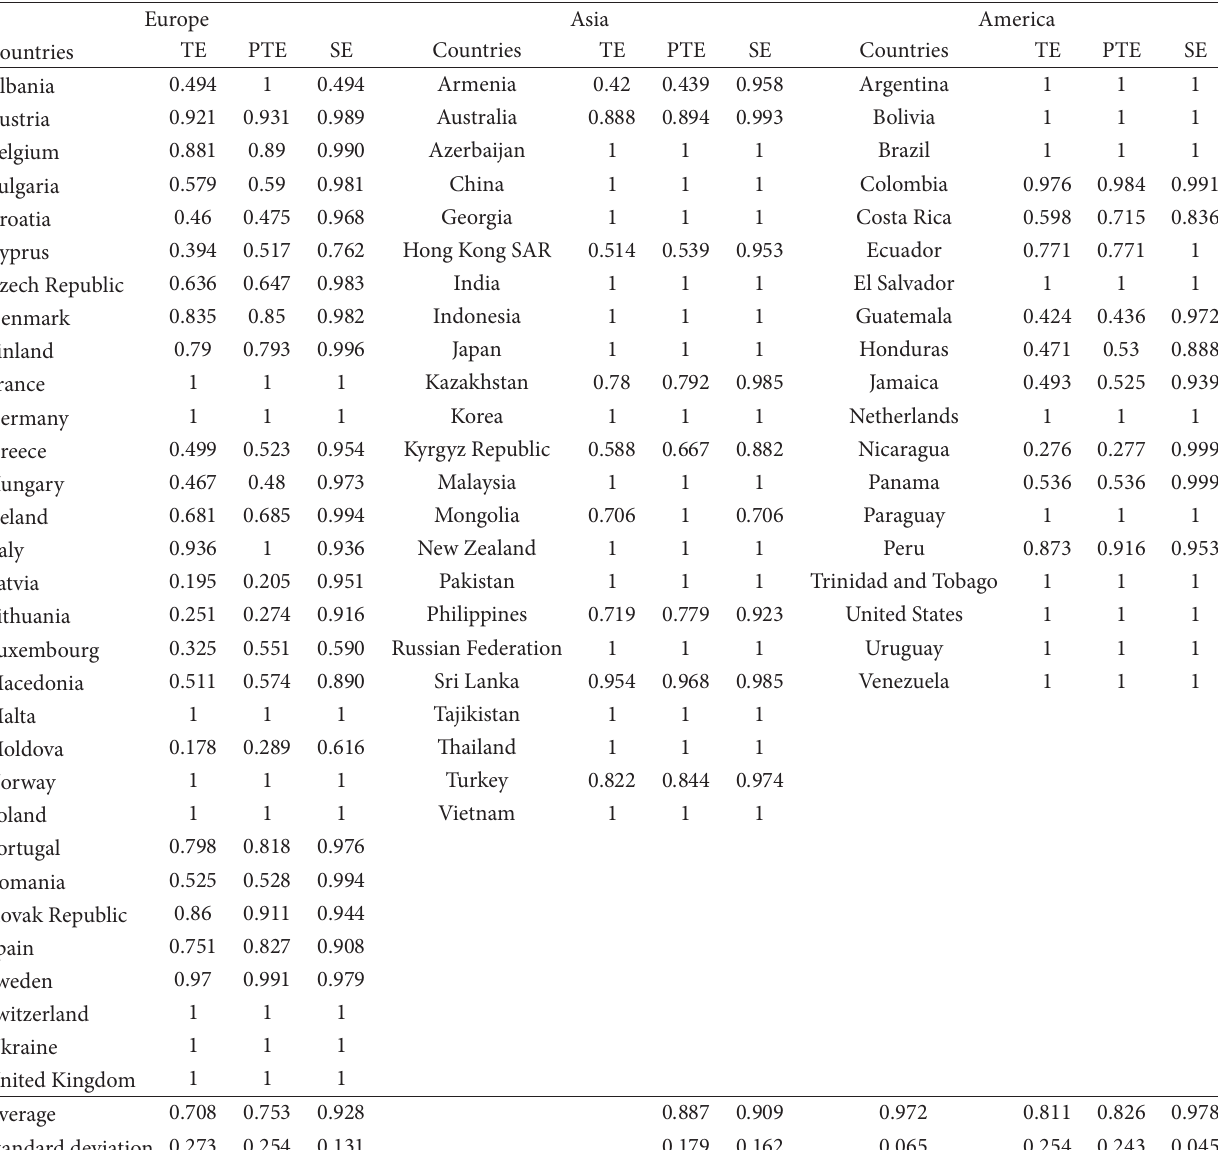
Table 2: Efficiency scores for 73